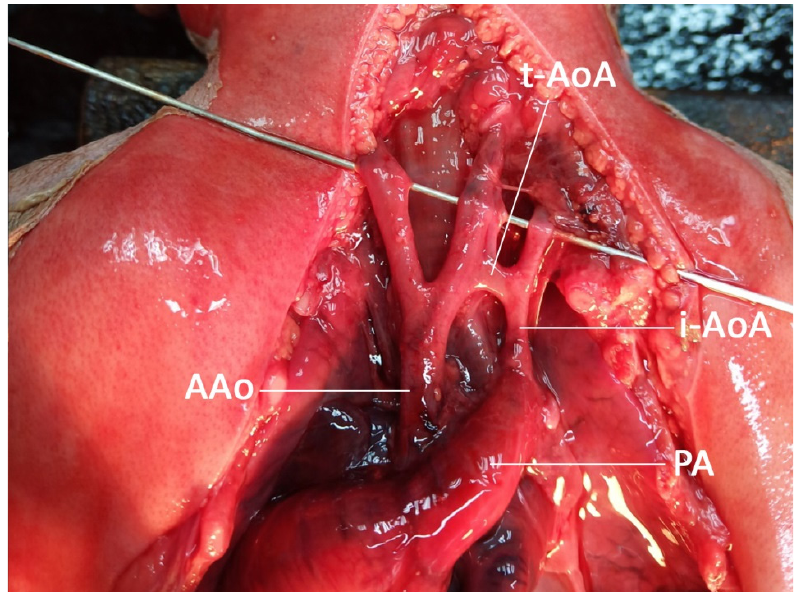
Figure 4. Autopsy finding shows coarctation of the aorta with tubular hypoplasia. (AAo: ascending aorta; i-AoA: isthmic aortic arch; t-AoA: transverse aortic arch; PA: pulmonary artery).